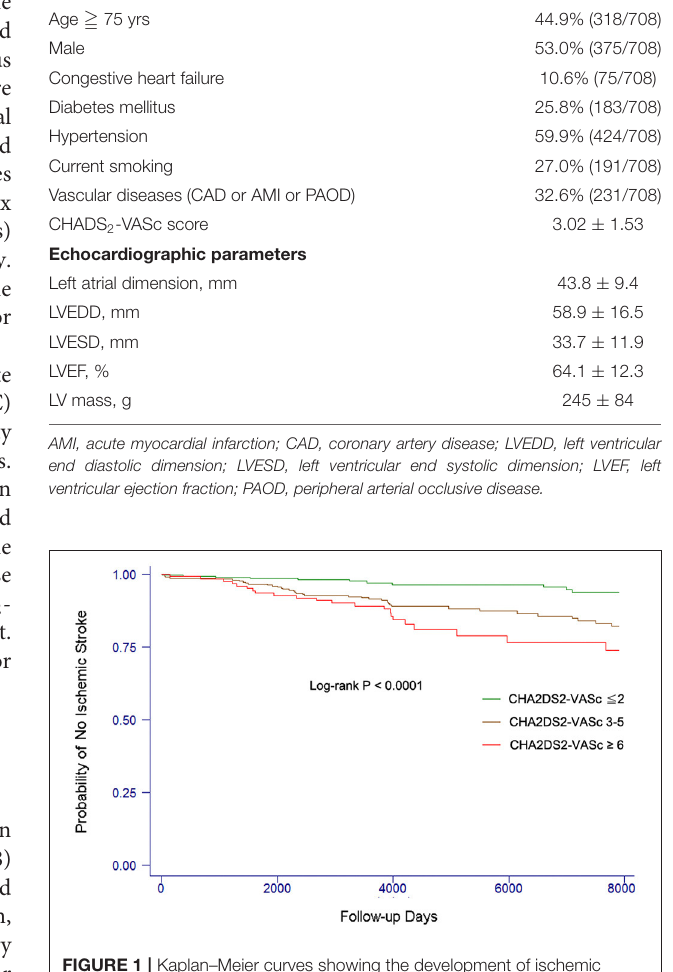
FIGURE 1 | Kaplan–Meier curves showing the development of ischemic stroke among patients with different levels of CHA 2 DS 2 -VASc score. The log-rank analysis showed significant difference ( P <